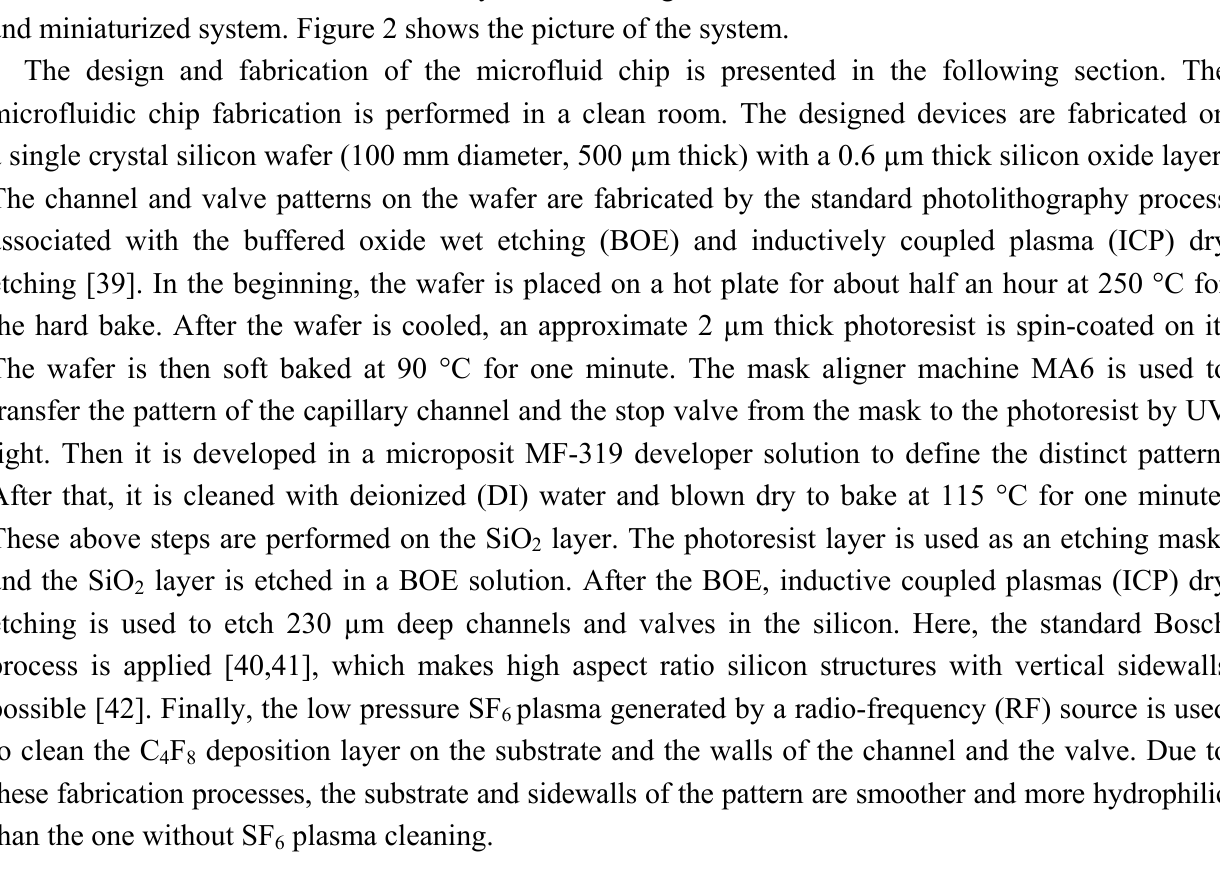
Figure 3. The capillary channels and microvalves patterns are fabricated on a